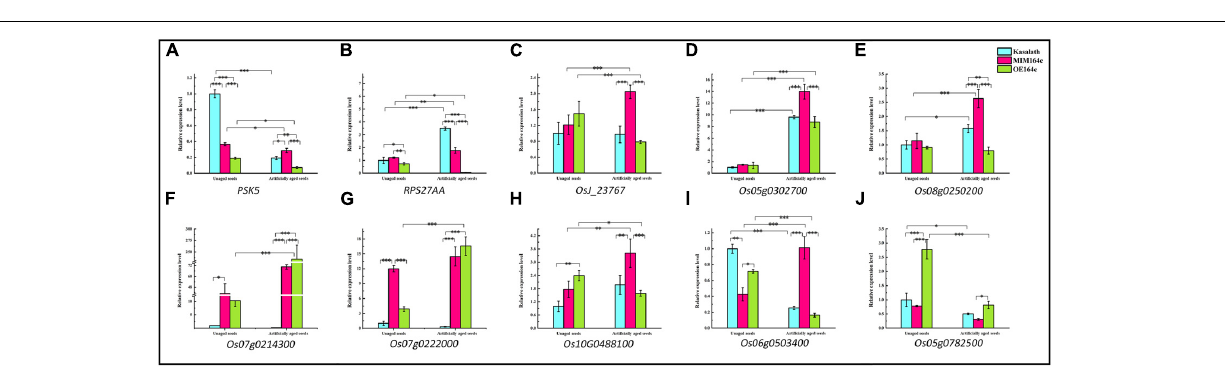
FIGURE 11 | Validation of the RNA-seq data of 11 DEGs by RT-qPCR. Data represent mean ± SD ( n = 3).